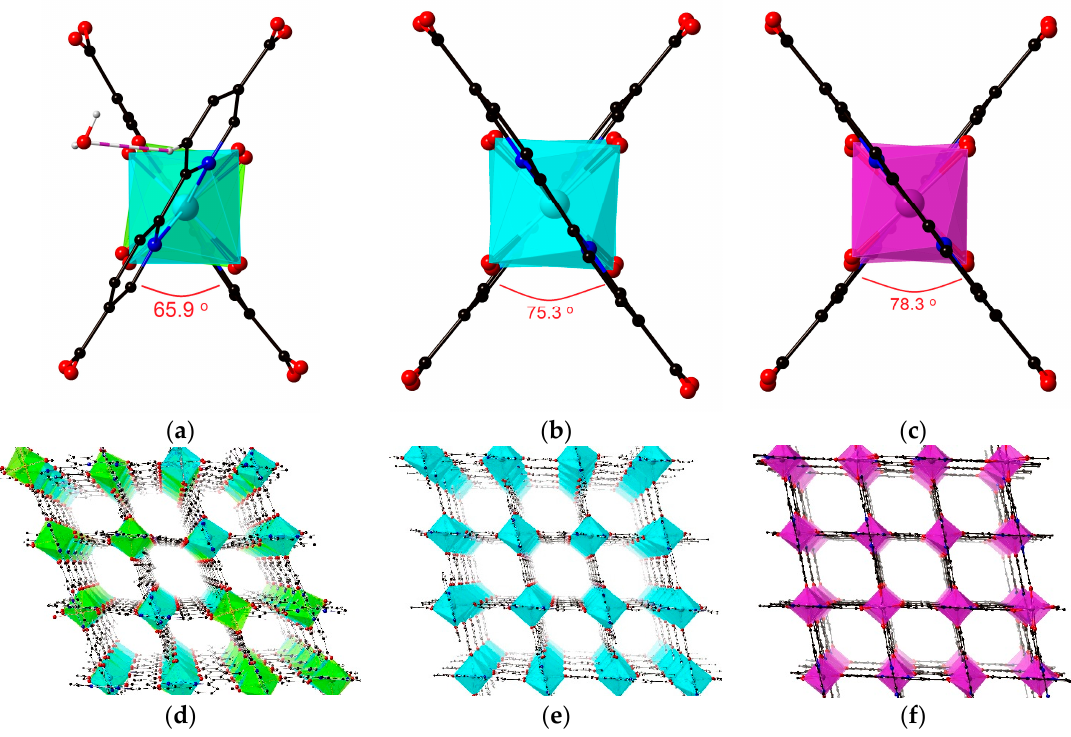
Figure 3. The difference in dihedral angles in the dinuclear units for 1 ( a ), 2 ( b ), and 3 ( c ) between the bipyridyl planes resulting in the different distortions of the 3D coordination frameworks, respectively ( 1 ( d ), 2 ( e ), and 3 ( f )). The hydrogen bonding interaction in (a) impels the different distortions of two pyridyl planes.